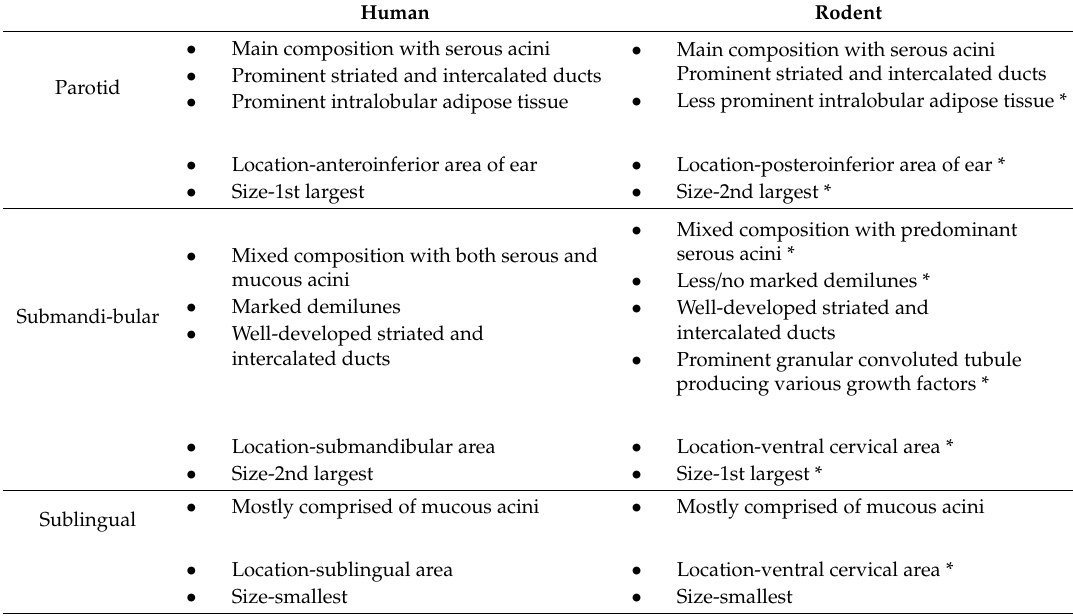
Table 5. Comparative anatomical and histological findings of major salivary